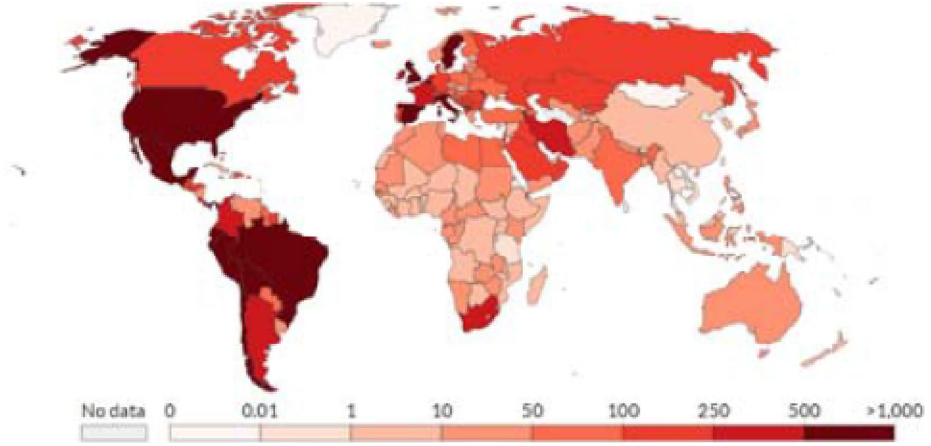
Figure 1. Global Distribution of COVID-19 Deaths Per Million People. Source: European Centre for Disease Prevention and Control.